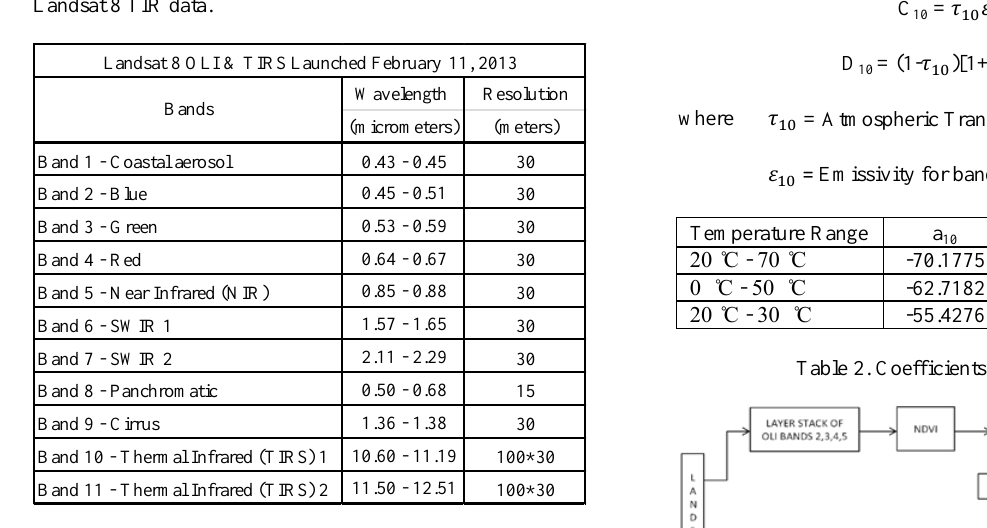
Table 1. Properties of Landsat 8 OLI & TIRS [9].